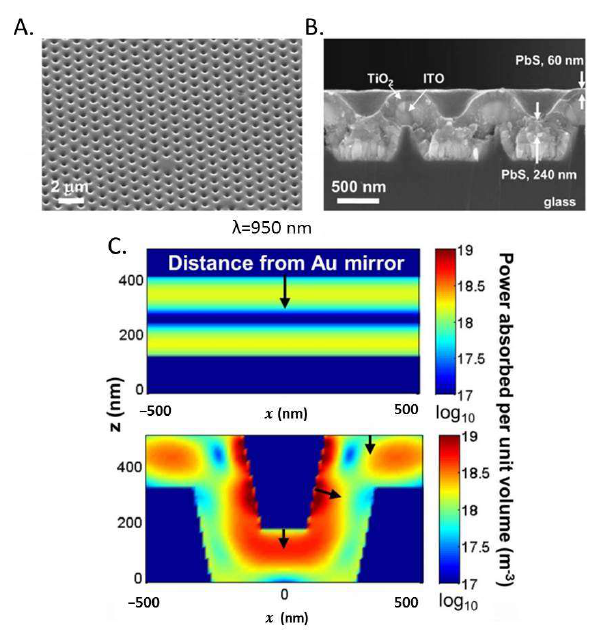
Fig. 6. (A) Forty-five degree tilt angle and (B) cross-sectional scan- ning electron microscope images of a periodically patterned glass/ITO/TiO 2 solar cell electrode with conformal PbS CQD layer coating. (C) Finite difference time domain simulation of power ab-